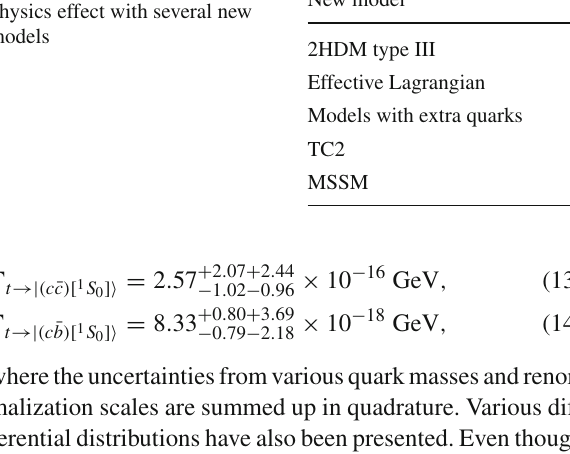
Table 6 The estimation of new physics effect with several new